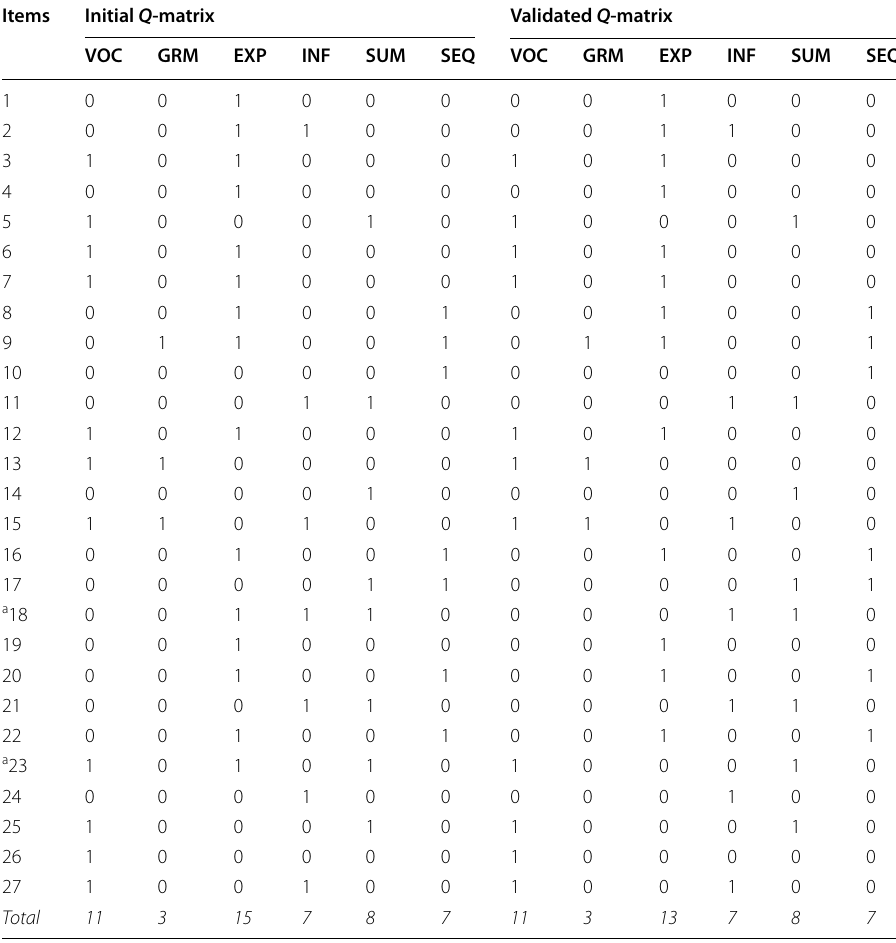
Table 4 The initial and final expert-defined Q -matrix after empirical validation